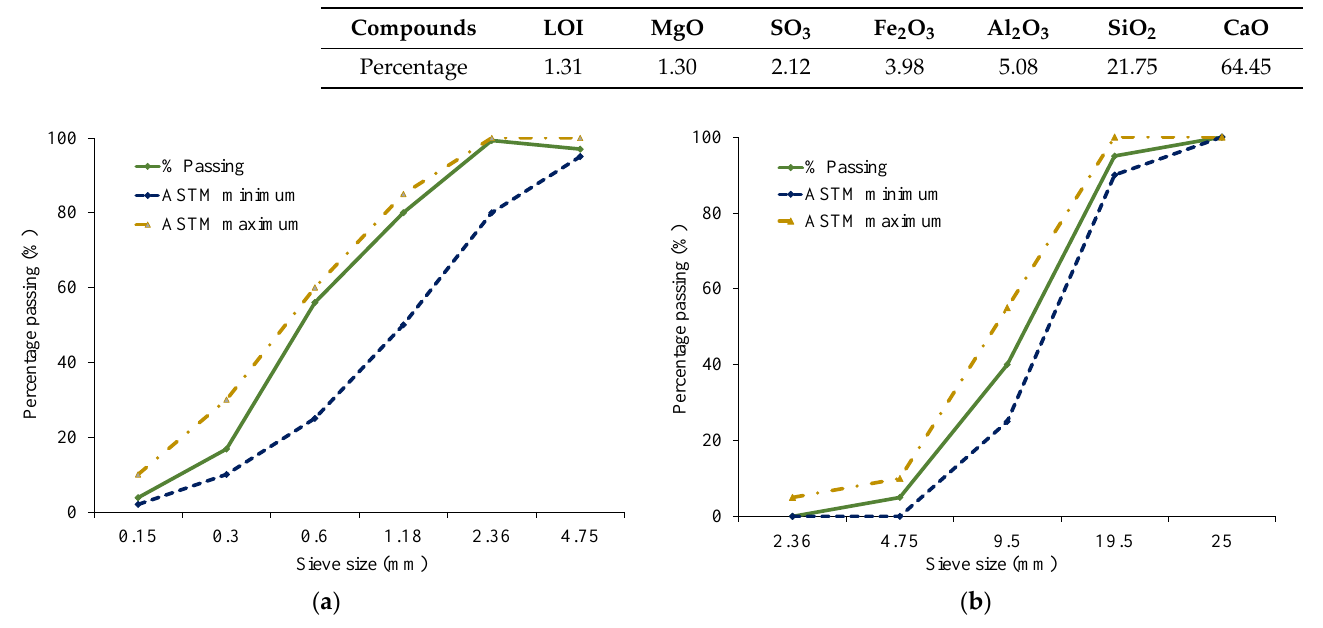
Figure 1. Sieve analysis of used aggregates ( a ) fine aggregates, ( b ) coarse aggregates. Table 1. Chemical properties of the used cement.